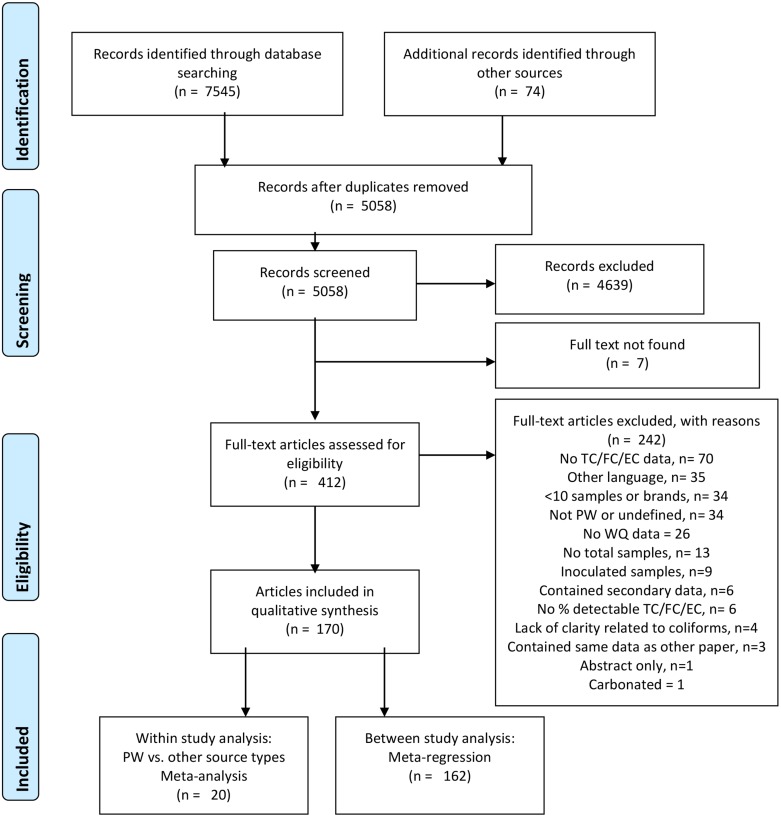
PRISMA flowchart.Results of literature search and screening according to PRISMA flowchart for systematic review screening process (Adapted from Moher et al. 2009).